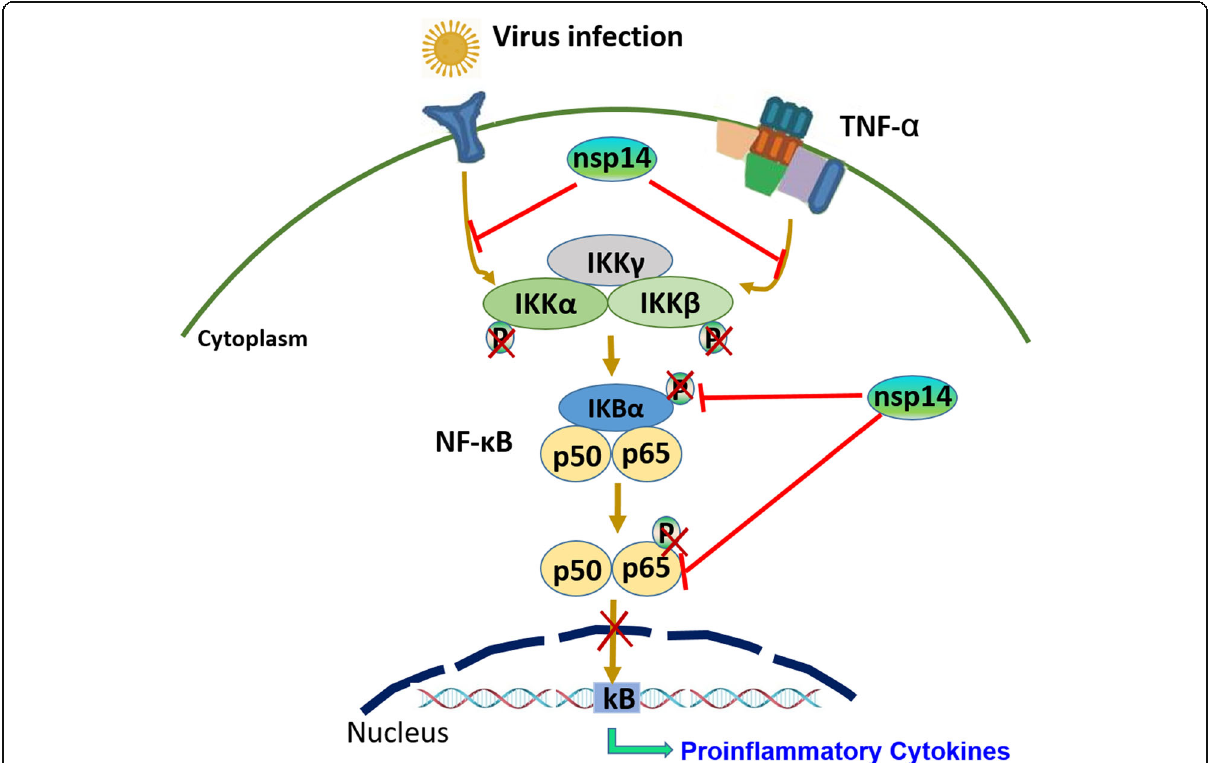
Fig. 8 Schematic diagram of PEDV nsp14 targets IKK complex and p65 to inhibit NF- κ B activity. PEDV nsp14 negatively regulates NF- κ B signaling pathway by interacting with IKK α / β and p65, which inhibits the phosphorylation of IKK α / β and p65, and nuclear translocation of NF- κ B, leading to the decreased expression of early production of proinflammatory